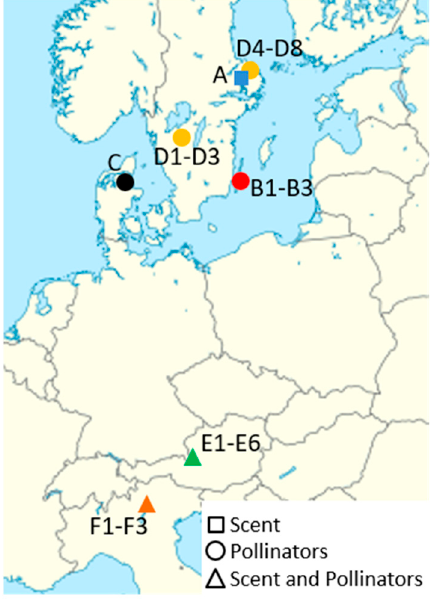
Figure 1. Regions and study sites at different latitudes in Europe, where data on pollinators (circles), scents (squares), or both (triangles) were collected in the present study or available from literature. Data included in the present study were from Scandinavia ((A) Bergström et al. [18]; (B) Nilsson [21]; (C) Erneberg and Holm [23]; (D) Antonelli et al. [22]), the Northern Alps ((E) Braunschmid et al. [12] and this study), and the Southern Alps ((F) this study). With the exception of A and C, where a single population was sampled, three to six populations were sampled per study area.